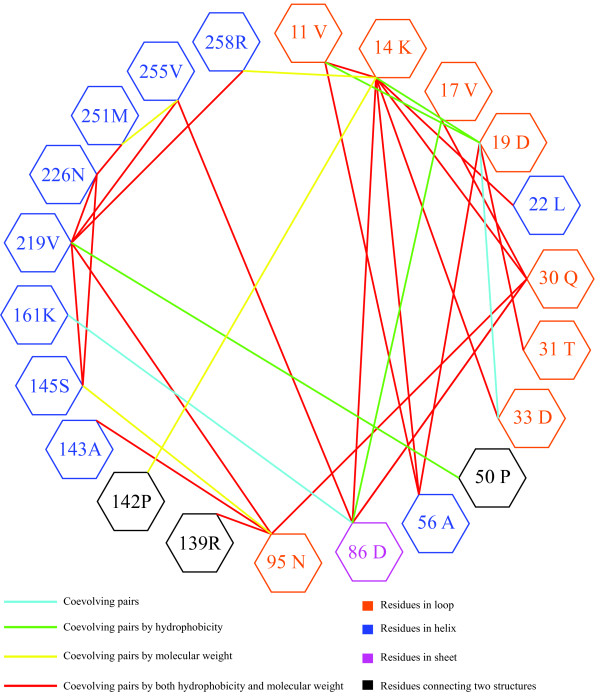
Coevolutionary networks in the RbcL subunit of the three gymnosperm families. Residues in the networks are sorted clockwise in an ascending order depending on the number of coevolutionary interactions that each amino acid residue establishes. The domains to which these amino acid sites belong are colour-coded. Nodes (amino acid residues) are connected through edges differently according to the nature and characteristics of their coevolution.